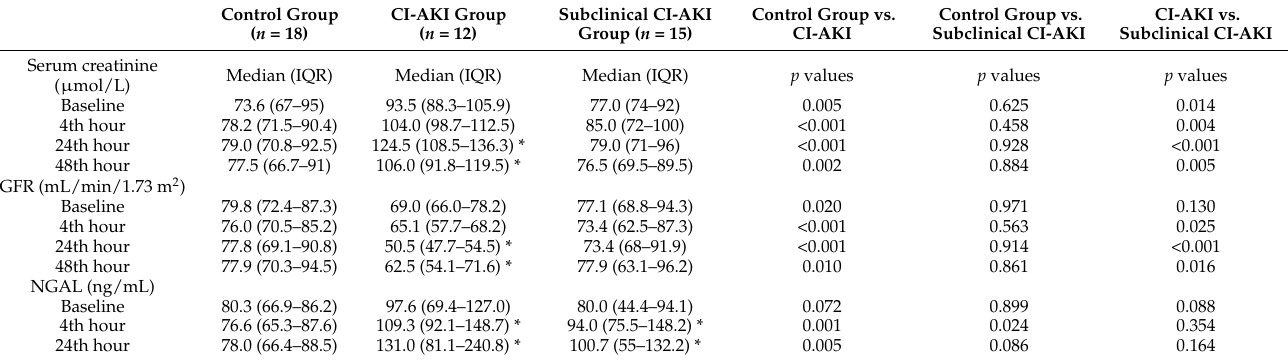
Table 2. Presentation of serum creatinine, glomerular filtration, and NGAL in the different